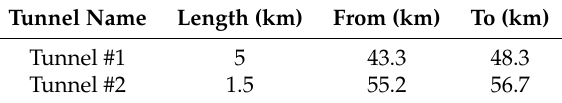
Table 4. Tunnels’ position.